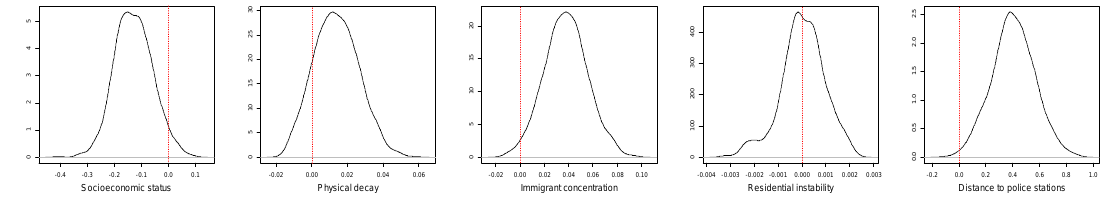
Figure 2. Posterior distribution of fixed effects in the model.